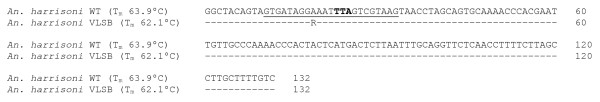
Sequences of the DIIS6 region of the para-type sodium channel gene obtained for An. harrisoni mosquitoes with respectively a Tm of 63.9°C (wild type, WT) and 62.1°C. Sequences of the 132 bp fragment of theDIIS6 region of the para-type sodium channel gene obtained after amplification with primers MinF-ROX and FunminR of An. harrisoni mosquitoes with respectively a Tm of 63.9°C (wild type, WT) [GenBank: EU155387] and a Tm of 62.1°C (VSLB) [GenBank: EU258605] in the FRET/MCA. The triplet TTA at codon 1014 is given in bold, while the hybridization place of the probe is underlined. A line (-) indicates a nucleotide identity compared to the wild type An. harrisoni sequence. R = heterozygote A/G